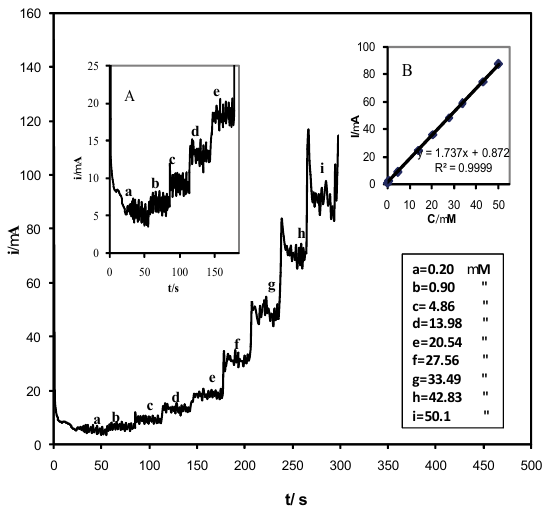
Figure 6. Amperometric response of ZMCCE kept in 650 mV in phosphate buffer solution pH 7 containing different concentrations of Piroxicam from 0.20 to 50.10 μ M (a- i). Insets: (A) the same amperograms in the time range of 0-200 s; (B) calibration plot for concentrations of Piroxicam.